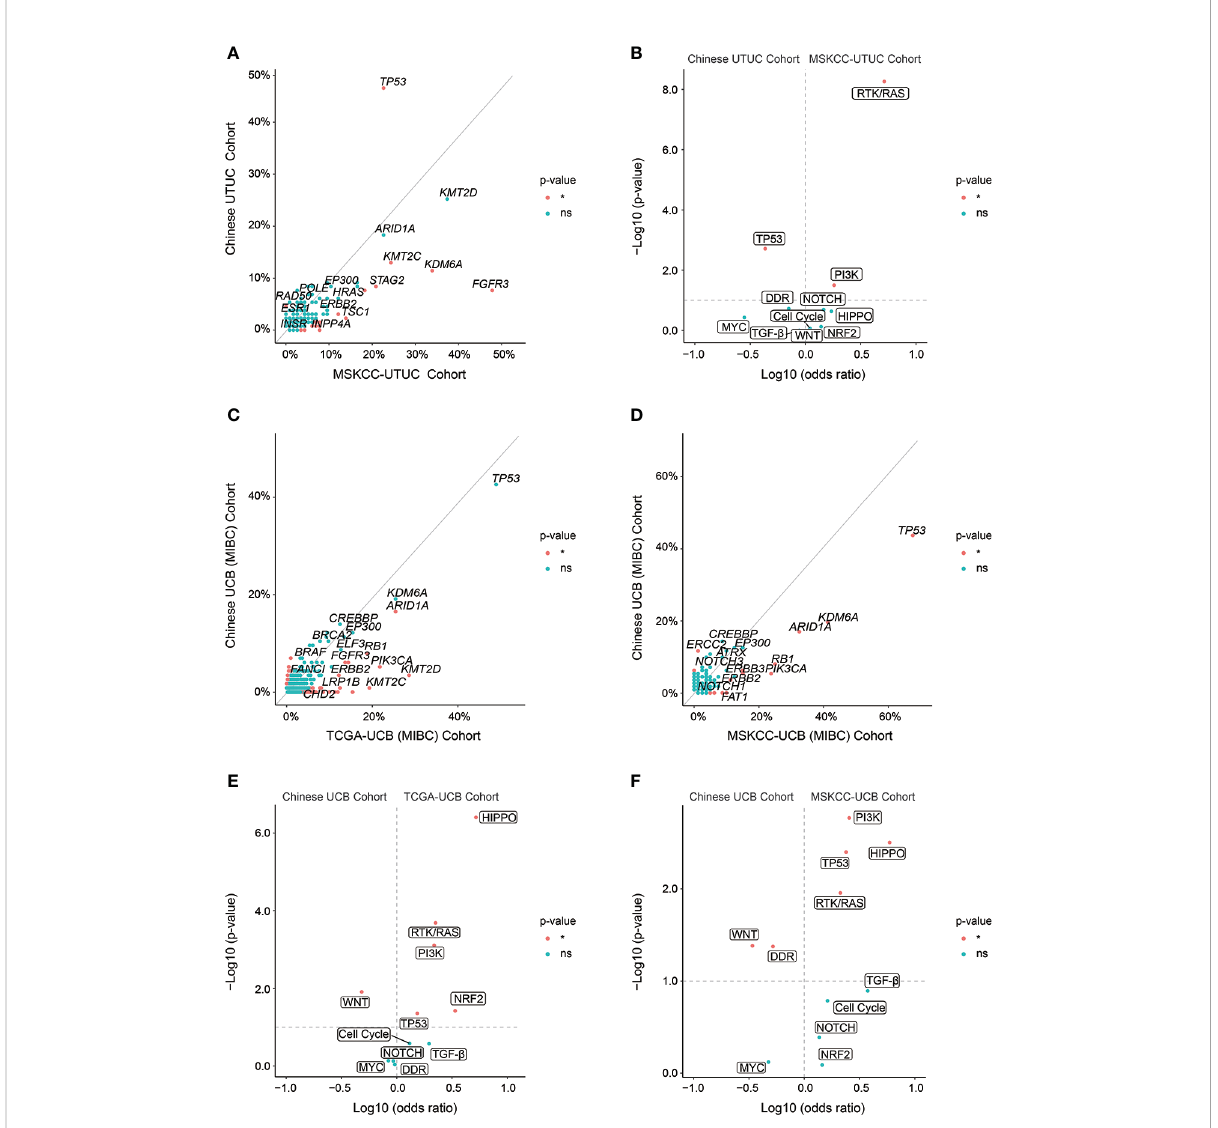
FIGURE 8 Genomic differences of UTUC or UCB between Chinese and Western cohorts. (A) Enrichment of GAs, respectively in Chinese UTUC and MSKCC-UTUC cohorts. (B) The frequency of altered molecular pathways [Log 10 (odds ratio)] by signi fi cance [ − Log 10 (p-value)], respectively in Chinese UTUC and MSKCC-UTUC cohorts. Enrichment of GAs, respectively in Chinese UCB and TCGA-UCB cohorts (C) , and respectively in Chinese UCB and MSKCC-UCB cohorts (D) . The frequency of altered molecular pathways [Log 10 (odds ratio)] by signi fi cance [ − Log 10 (p-value)], respectively in Chinese UCB and TCGA-UCB cohorts (E) , and respectively in Chinese UCB and MSKCC-UCB cohorts (F) . *: p < 0.05. ns, not signi fi